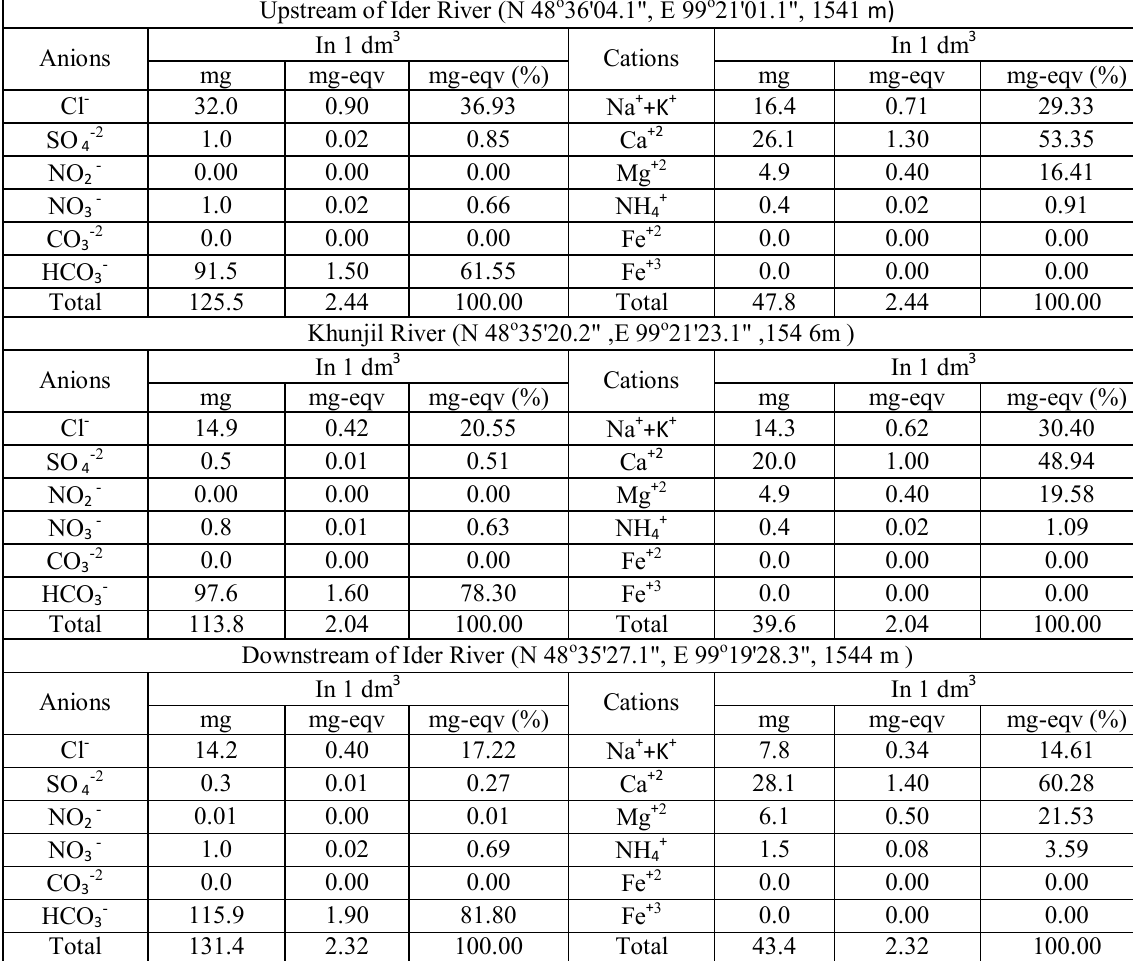
Table 2 . Ions in Ider and Khujil